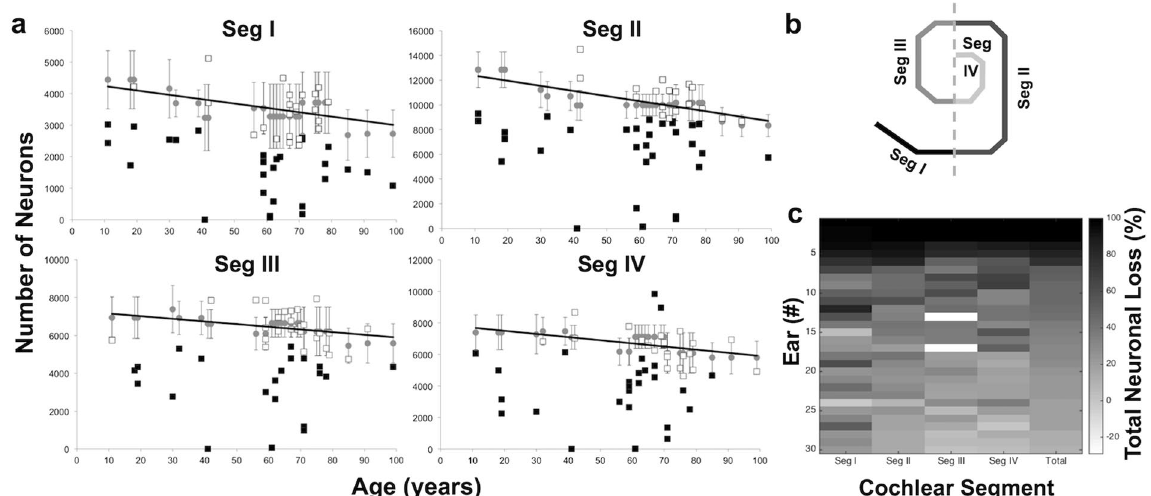
Figure 2. Patients with severe neural degeneration show abnormally low SGN counts with respect to age. SGNs quantified by cochlear segment in 51 ears from 34 patients. ( a ) Gray circles: published age-based mean with standard deviation and linear regression (Makary et al ., 2011); black squares: patients with SGN counts greater than one standard deviation below the age-based mean; white squares: all other patients. ( b ) Schematic of cochlear segments, as in Makary et al ., 2011. ( c ) Heat map of 30 ears from 23 patients exhibiting total neuronal loss (%) greater than one standard deviation below the age-based mean; each line represents a single